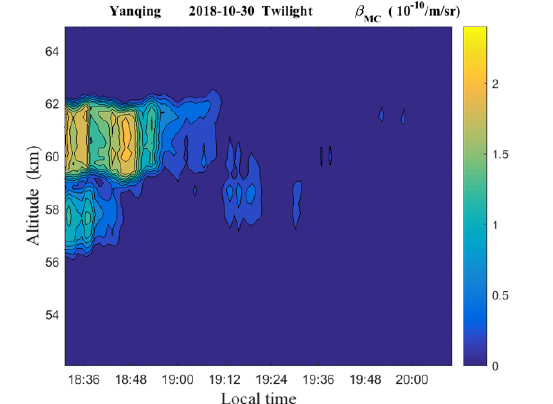
Fig. 1 . Contour plot of the volume backscatter coefficient showing the time evolution of MC layer observed at Yanqing (40.5°N, 116°E) in the dawn on 30 October 2018.